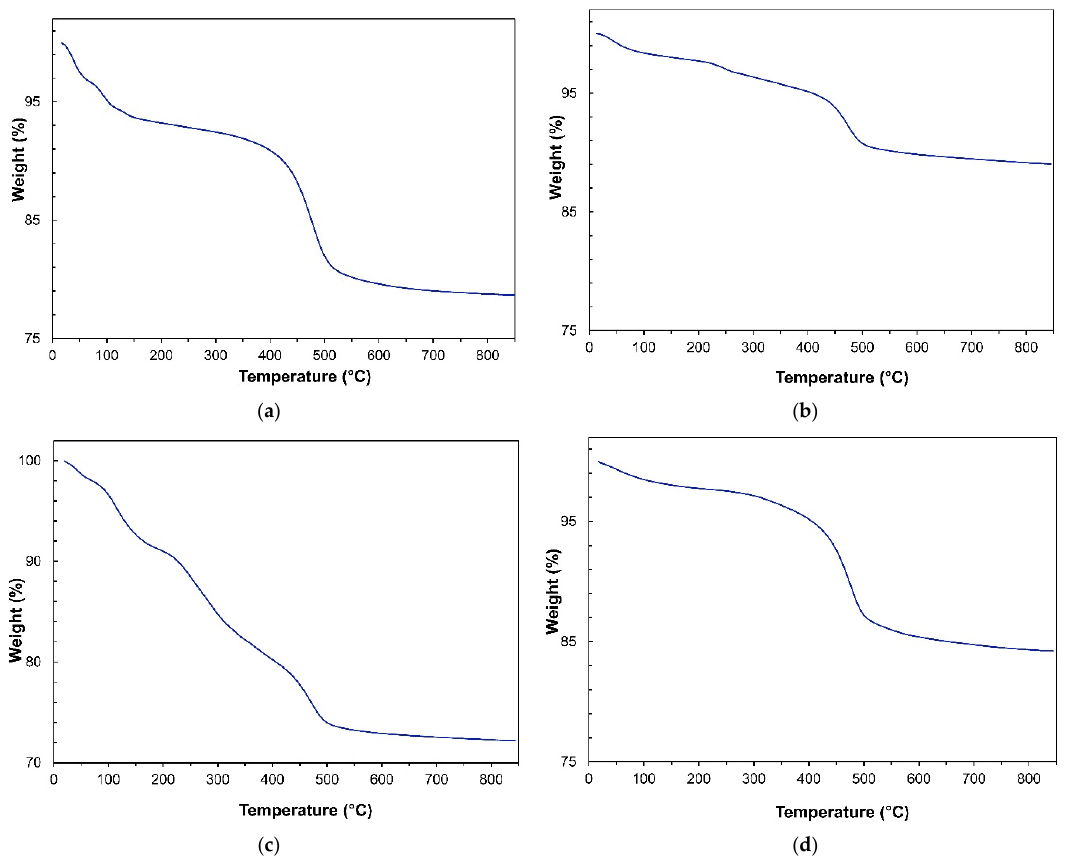
Figure 5. TGA curves of ( a ) commercial HNT ( b ) HNT/Fe3O4-C, ( c ) HNT/Fe 3 O 4 -H, and ( d ) HNT/Fe 3 O 4 -SG samples. Field dependence of magnetization was investigated for all the samples at 300 K (Fig- ure 6a,b).